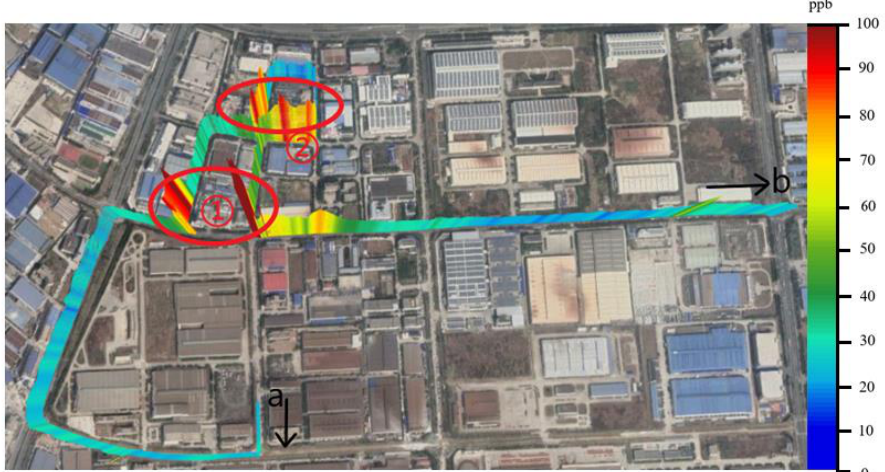
Figure 4. Distribution of the total VOCs (TVOCs) from the navigation monitoring. The height of the